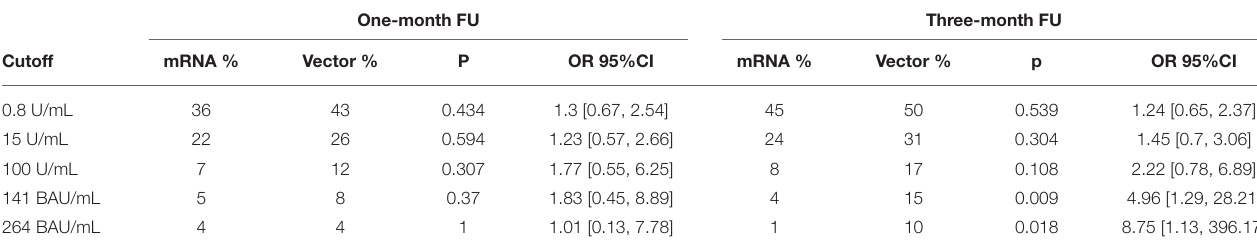
TABLE 2 | The response rate to 3 rd SARS-CoV-2 vaccination at different pre-specified cut-off levels for the 1- and 3-month follow-up.